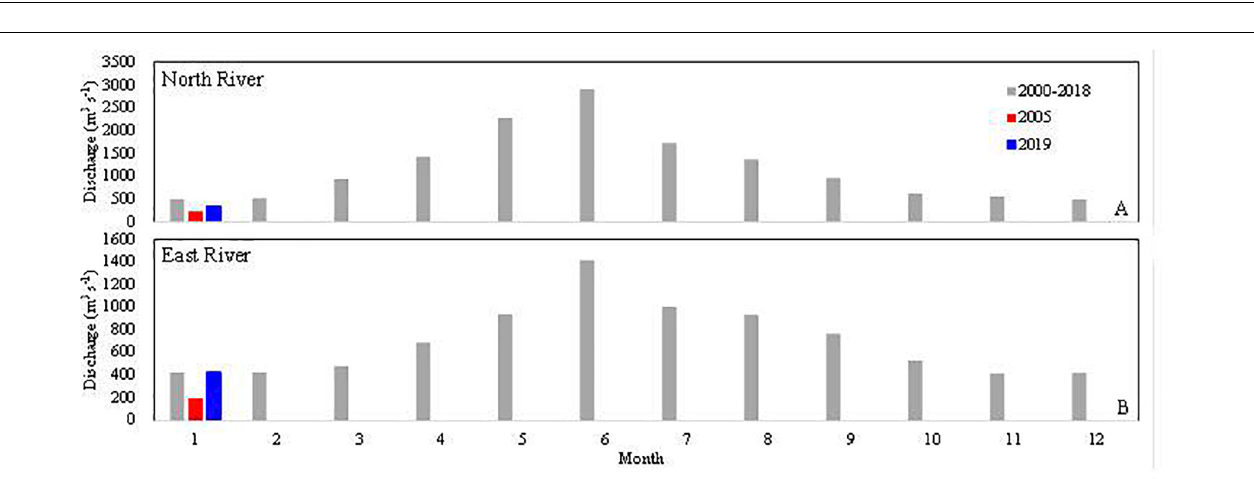
FIGURE 1 | The map of the Pearl River estuary with sampling stations (dots). HUM, JOM, HQM, HEM, MDM, JTM, HTM, and YM are the outlets of Humen, Jiaomen, Hongqimen, Hengmen, Modaomen, Jitimen, Hutiaomen, and Yamen. The black open circles mark the cities. LDY is the Lingdingyang; HMH is the Huangmaohai. The star is the incubation station. Data for the January 2005 cruise are from Guo et al. (2008).